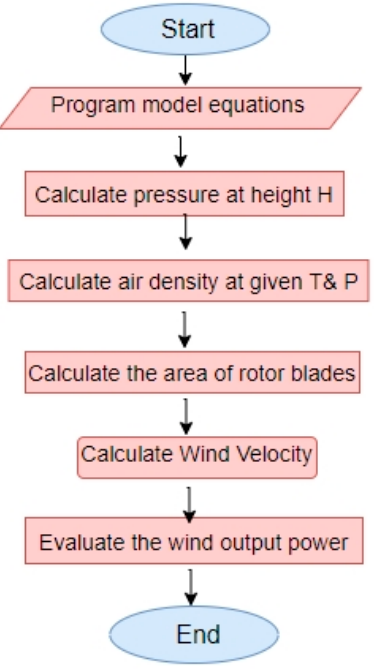
Figure 3. Flowchart for wind energy unit implementation in MATLAB.